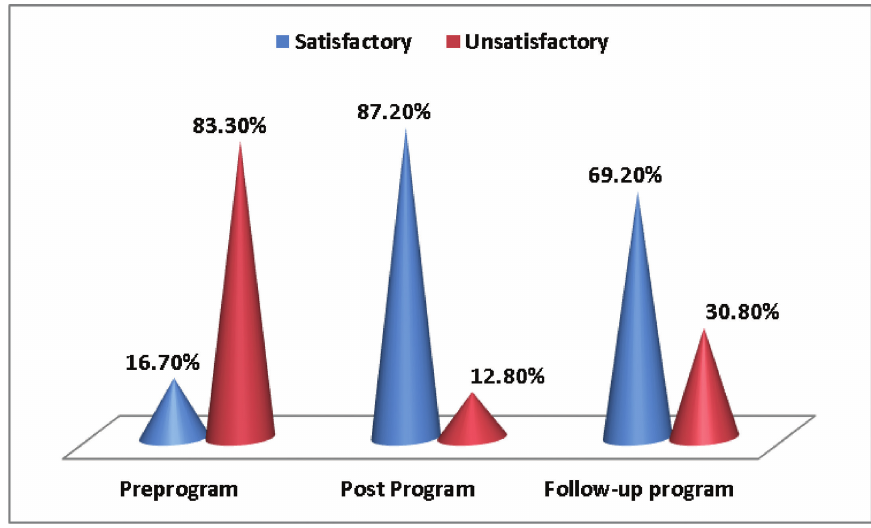
Figure 3. Frequency Distribution of Total Scores of Caregivers’ Observed Practice Regarding Pressure Ulcers Prevention throughout the Training Program ( n = 78). Table 4. Correlation between pre-, post-, and follow-up a total score of caregivers’ knowledge, practices, and attitude throughout the training program ( n = 78).